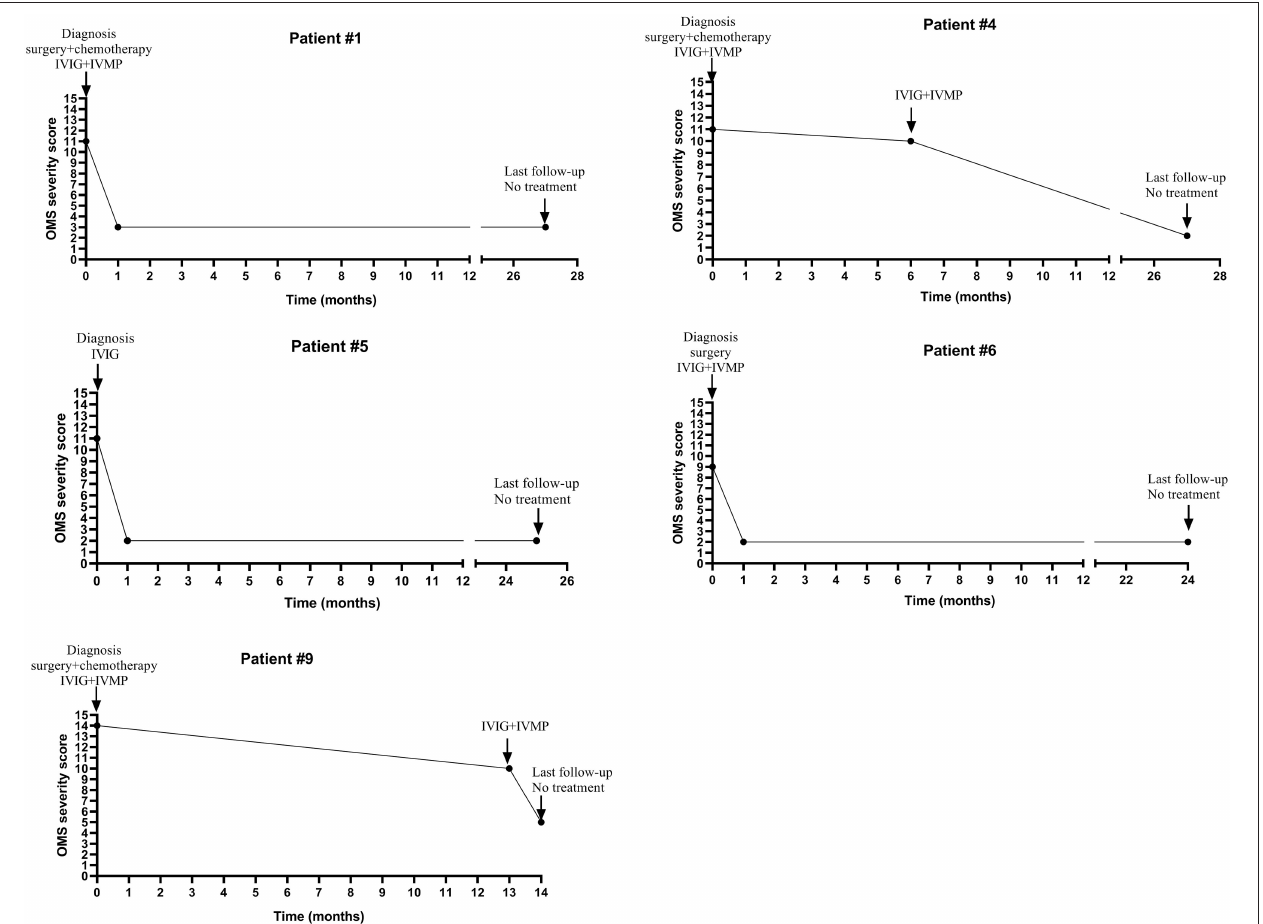
FIGURE 1 | The change of OMS severity score and immunotherapy of five patients with tumor or mass during the clinical course.